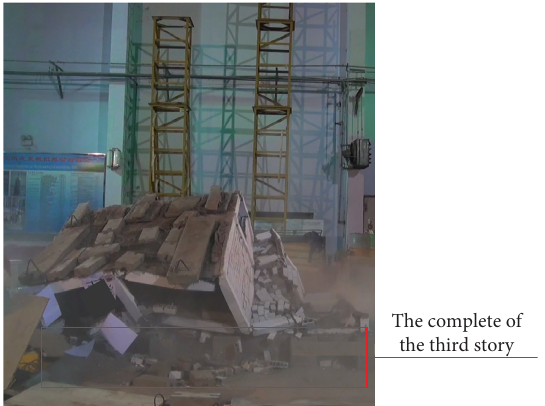
Figure 34: Third-floor collapse of the test (front).